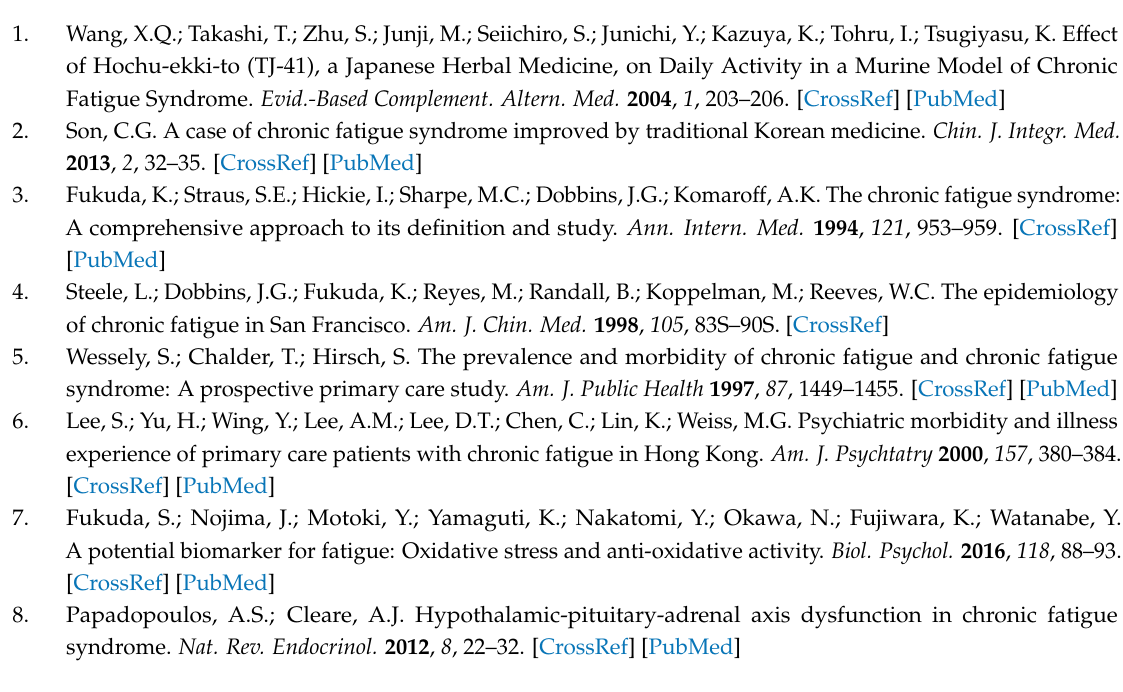
s1, Figure S1: Total ion chromatograms (TICs) of the urine samples obtained from the NC (A), CFS (B), and Se-TP groups